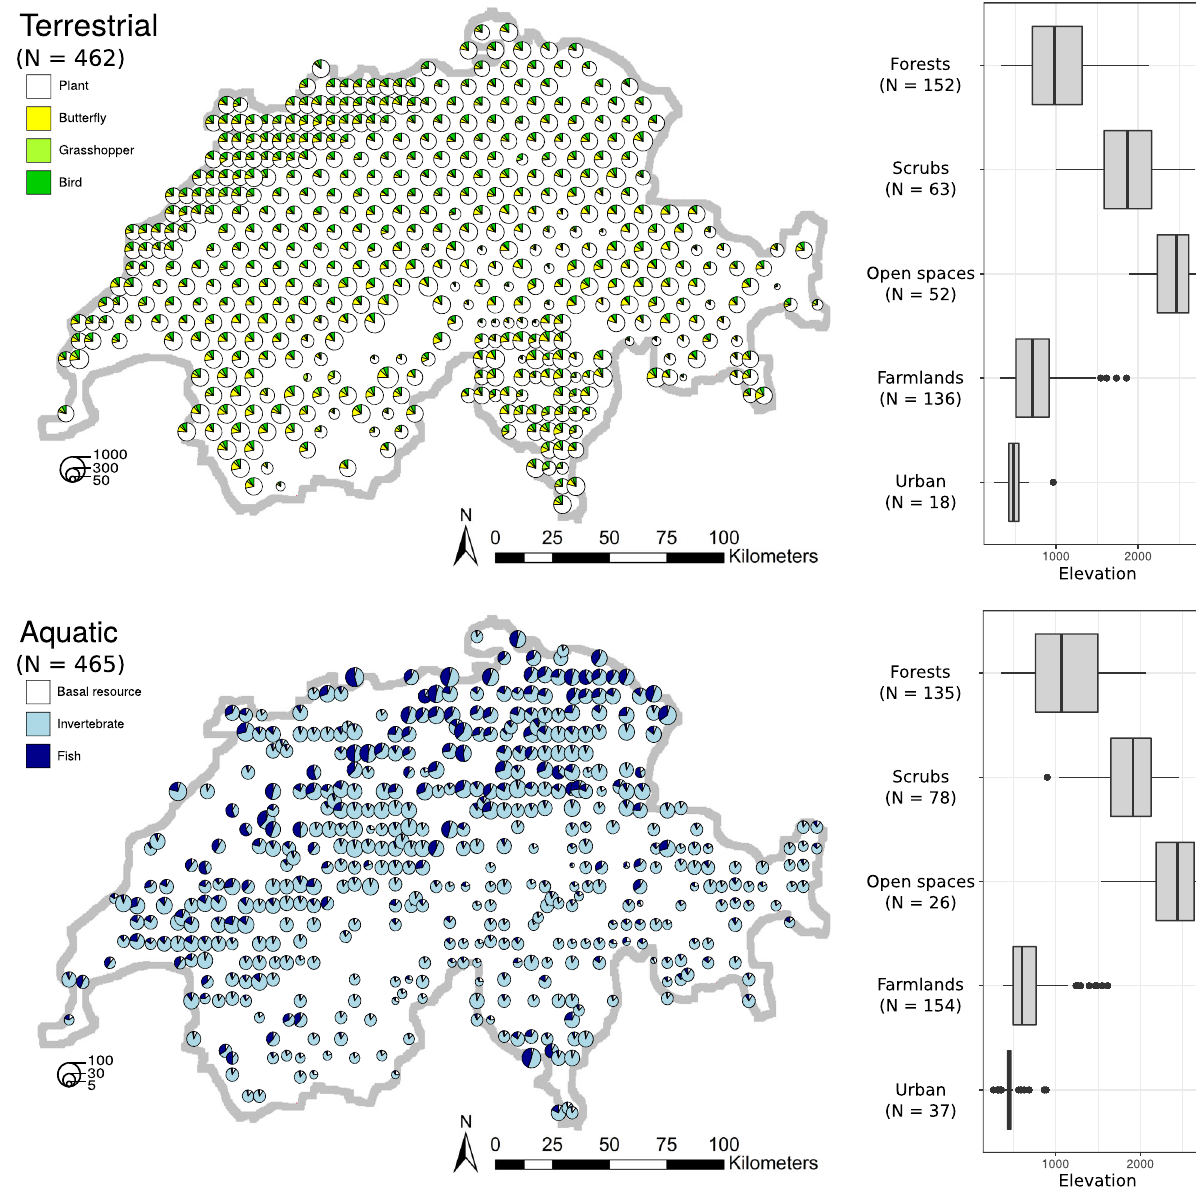
Fig.2|Terrestrial(toppanel)andaquatic(bottompanel)foodwebsassembled inthisstudy. Thefoodwebs ’ locationsacrossSwitzerlandarebasedonastrati fi ed, randomised raster approach, and thus representative for the landscape. The pie charts give the food webs ’ sizes (number of nodes, as the size of pie charts) and focal-group composition (colours). Note that the three assumptive mega nodes: